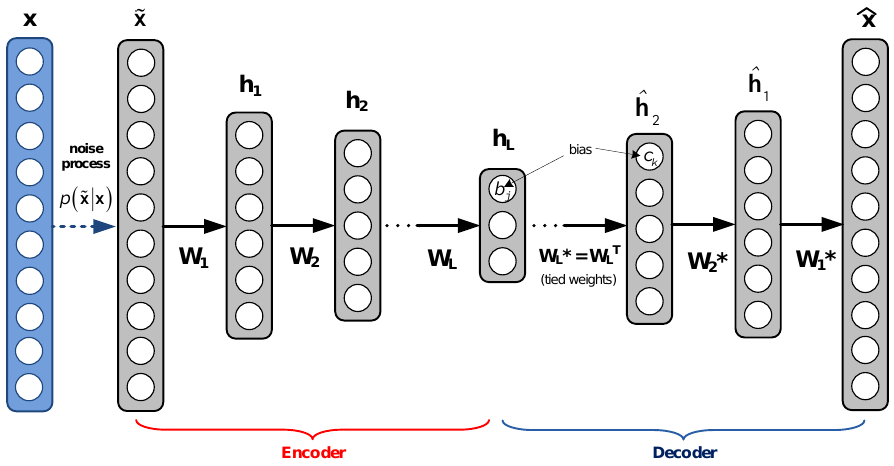
Figure 2. The structure of the considered SDAE. x , (cid:101) x and (cid:98) x are equal-size and real-valued vectors that represent the input, noise-corrupted and recovered data, respectively. W ∗ weight